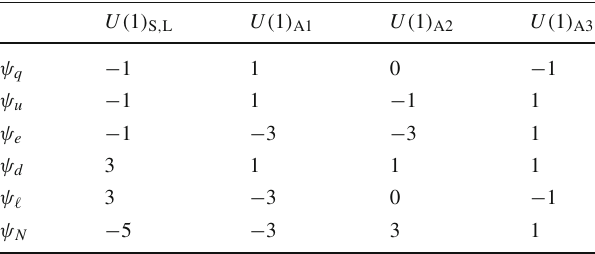
As in the toy model, at f (cid:7) f GUT the SU ( N c ) becomes strong and a non-trivial vacuum for the fermion bilinears